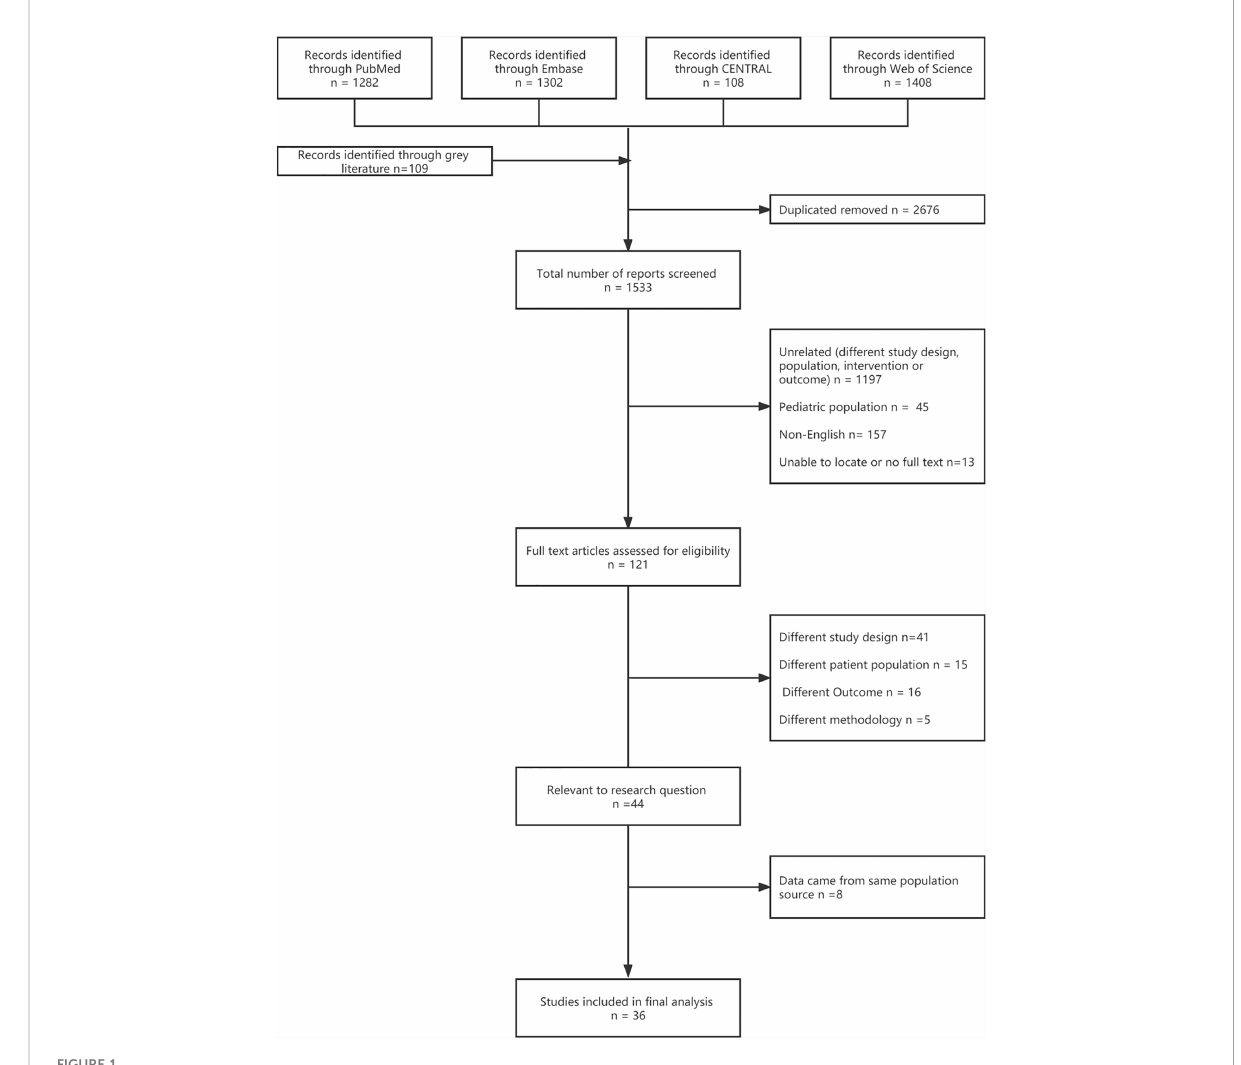
FIGURE 1 Study fl ow